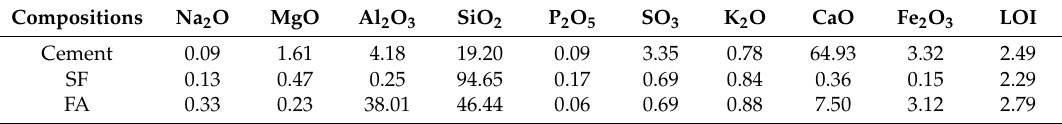
Table 1. Chemical compositions of the employed cementitious materials